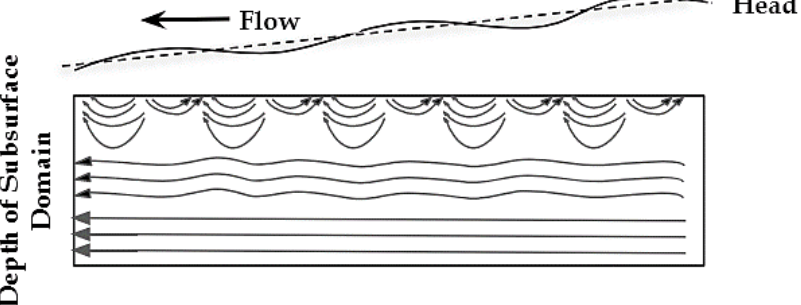
Figure 3. Depth and spatial pattern of hyporheic streamlines described as a function of the Hydraulic head gradient profile.